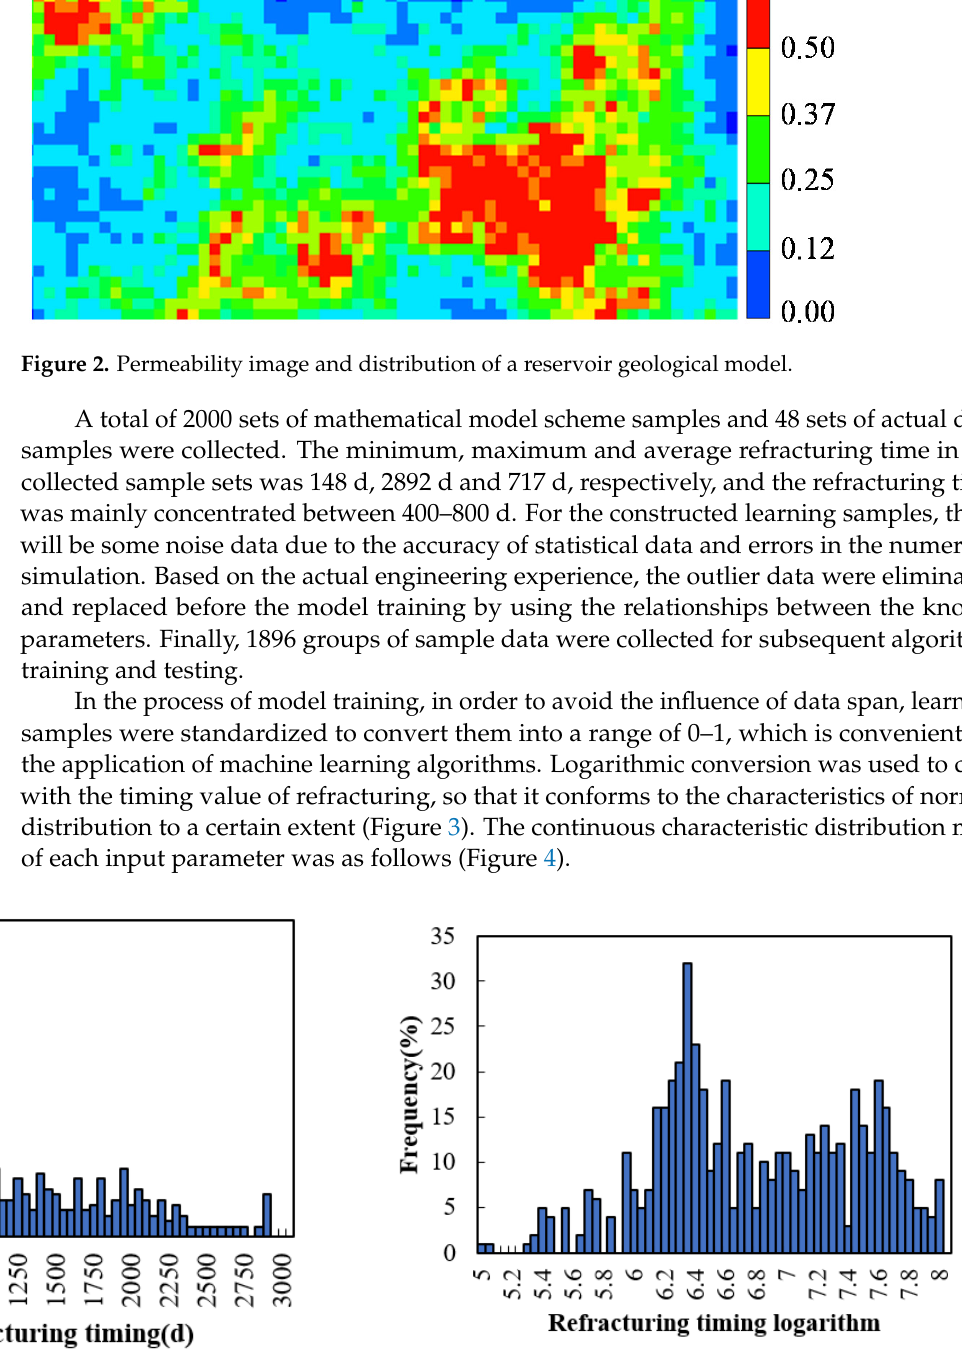
Figure 3. Comparison of Distribution before and after logarithmic transformation of refracturing timing.